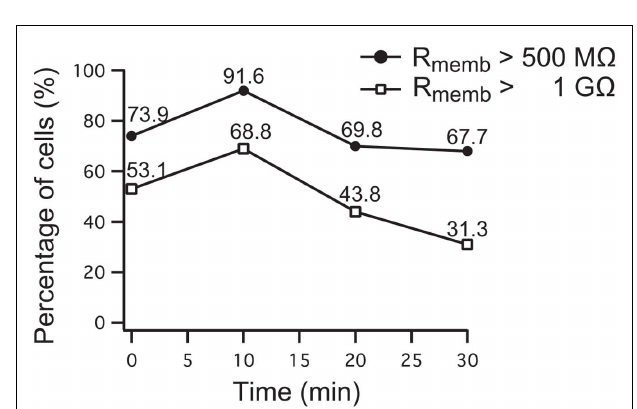
FIGURE 8 | Development of seal stability of 96 Na v 1.5 overexpressing HEK cells over time on the SyncroPatch 96. 69.8% of the cells had a stable membrane resistance of > 500M Ω (783 ± 29M Ω ) for 20min, 67.7% of the cells were stable until the experiment was finished after 30min. 43.8% of cells having a membrane resistance of > 1G Ω (1865 ± 99M Ω ) were stable for 20min, 31.3% of them still had a stable resistance after 30min. Note the increase of cell percentage developing a higher resistance within 10min after reaching the whole cell configuration.